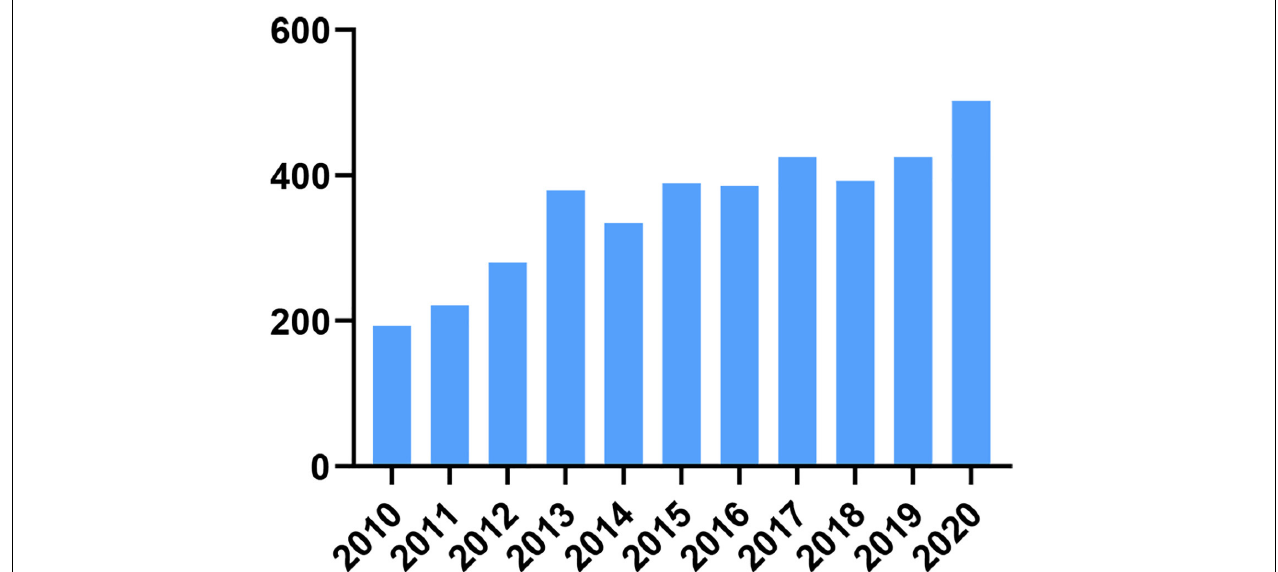
FIGURE 1 | Number of papers published in HUMSCs research in the last